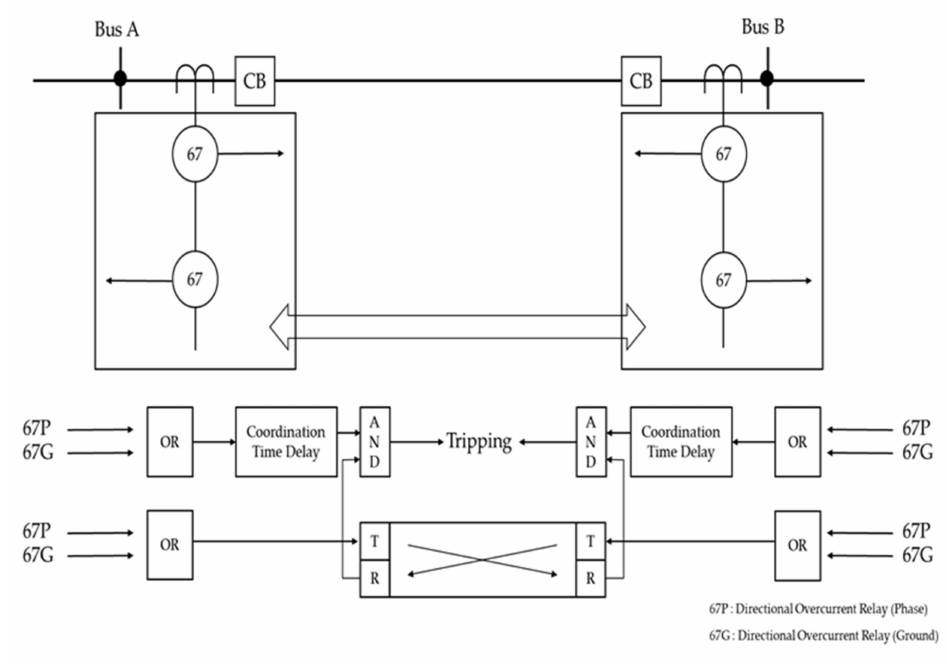
Figure 4. Principle of POTT